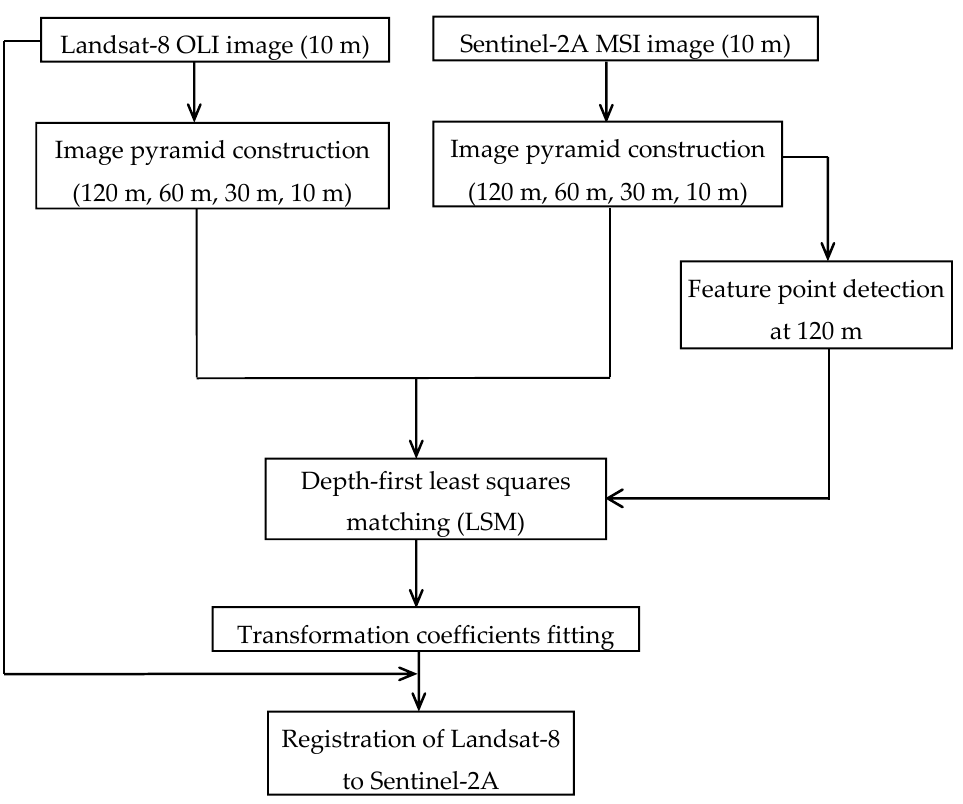
Figure 3. Automated workflow to register Landsat-8 OLI to Sentinel-2A MSI WELD tiles.